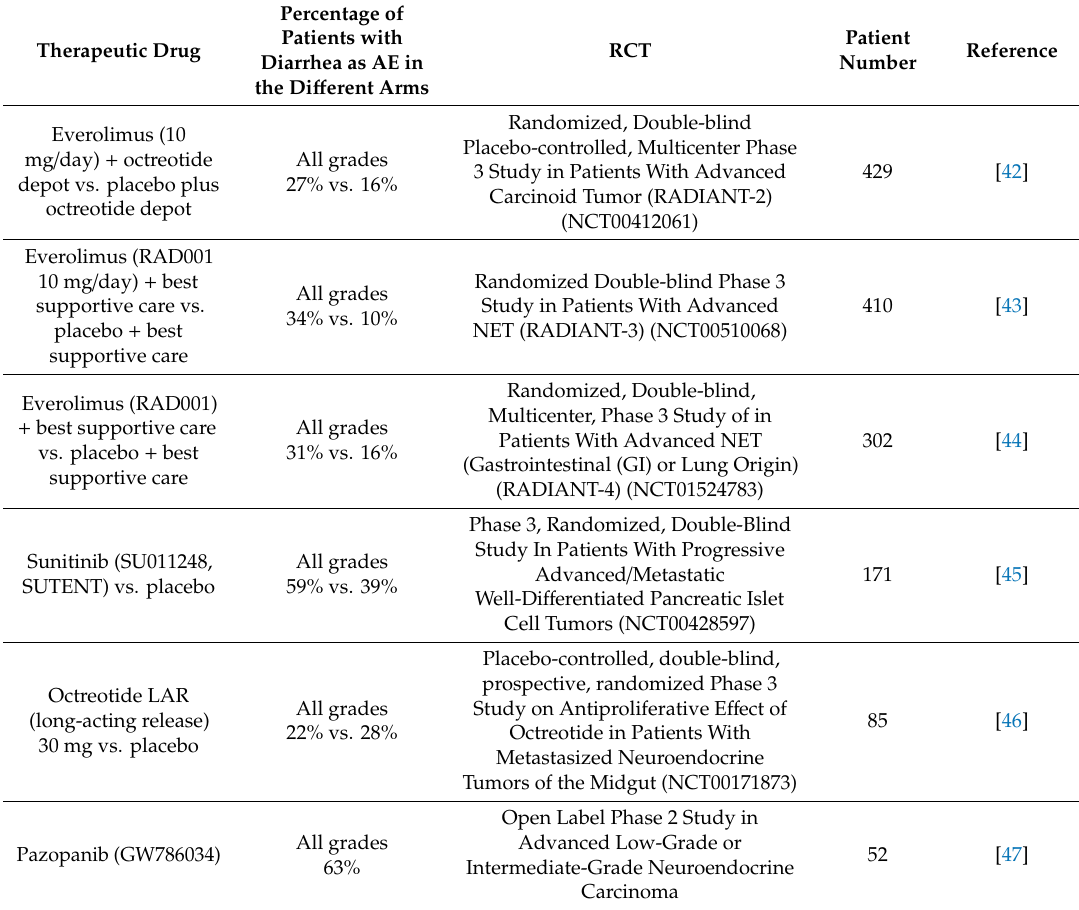
Table4. Incidenceofdiarrheaasadverseevent(AE)ofmedicaltreatmentsusedingastroenteropancreatic neuroendocrine tumors